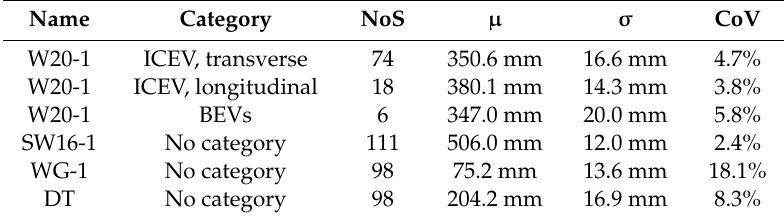
Table 2. Derived linear regressions showing the correlation between W20 and engine installation. Case Regression NoS R 2 internal combustion engine vehicles (ICEV), transverse engine Battery electric vehicles (BEVs) (purpose design) Table 3. Overview of the empirical values for the dimensional chain in the